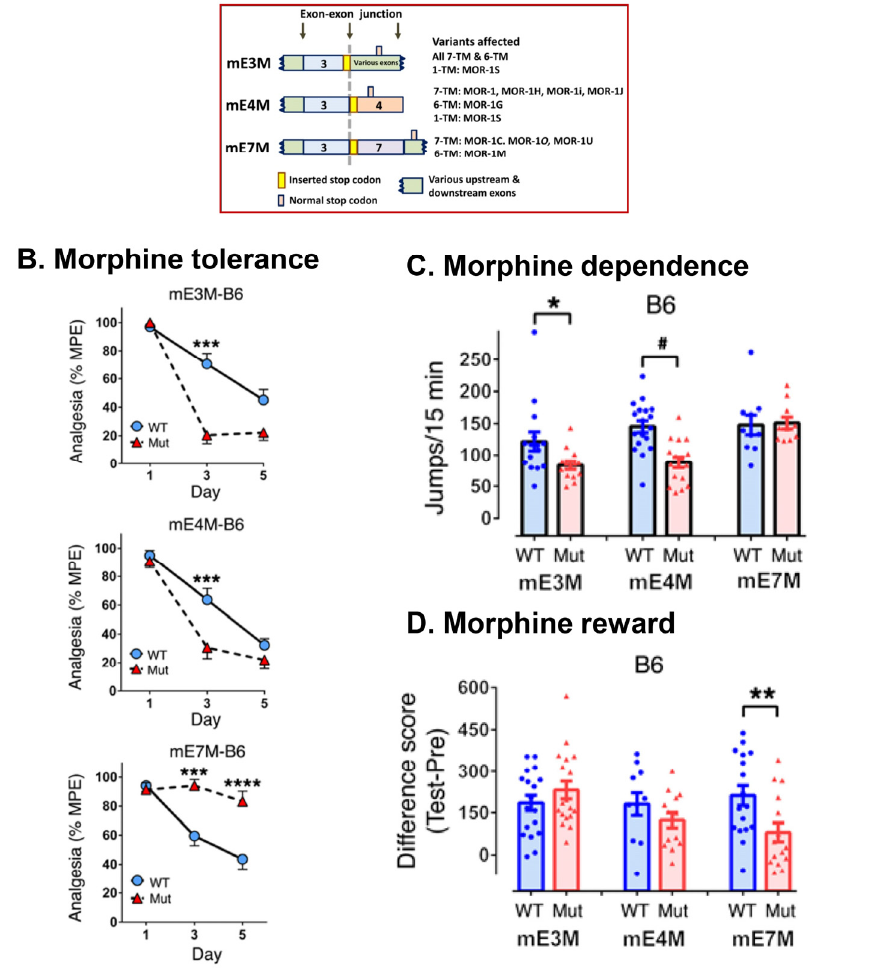
Figure 4. Oprm1 C-terminal truncation mouse models adapted from Xu et al. 2017 [83] . ( A ). Schematic of the strategy generating C-terminal truncation mouse models. Three targeted mouse models, mE3M, mE4M, and mE7M, were generated by inserting a stop codon at an appropriate site within indicated exons shown by colored boxes. Inserted and original stop codons are indicated by yellow and pink bars, respectively. In mE3M, a stop codon was inserted at the end of exon 3 to eliminate every C-terminal tails of all 7TM and 6TM variants, as well as 1TM mMOR-1S. In mE4M and mE7M, a stop codon was created at the beginning of exon 4 or exon 7 to eliminate individual C-terminal tails encoded by exon 4 or exon 7 of indicated variants, respectively. ( B ). Morphine tolerance in the mutant mice on C57BL/6J (B6) background was induced by twice daily injections with morphine (10 mg/kg, s.c.) for 5 days. Morphine analgesia was determined 30 min after s.c. injection using a radiant-heat tail-flick assay. Results are shown as the percentage of maximum possible effect (% MPE). WT, wildtype mice; Mut, homozygous mice. ***: compared to WT, p < 0.001, 2-way ANOVA with Bonferroni’s post hoc test. ( C ). Morphine physical dependence was assessed on day 5 of chronic morphine treatment with naloxone (s.c.,1.0 mg/kg) injection 3 h after the last morphine treatment to precipitate withdrawal. The number of jumps within 15 min was used for the measurement of withdrawal. *: p < 0.05; #: p < 0.0001, compared with WT, 1-way ANOVA with Bonferroni’s post hoc test. ( D ). Morphine reward was assessed using a 6-day conditioned place preference protocol. **: p < 0.01, compared with WT, 1-way ANOVA with Bonferroni’s post hoc test. Figure ( A – D ) were adapted from Figure S2, Figures 1 and 2 of Xu et al. 2017 [83],